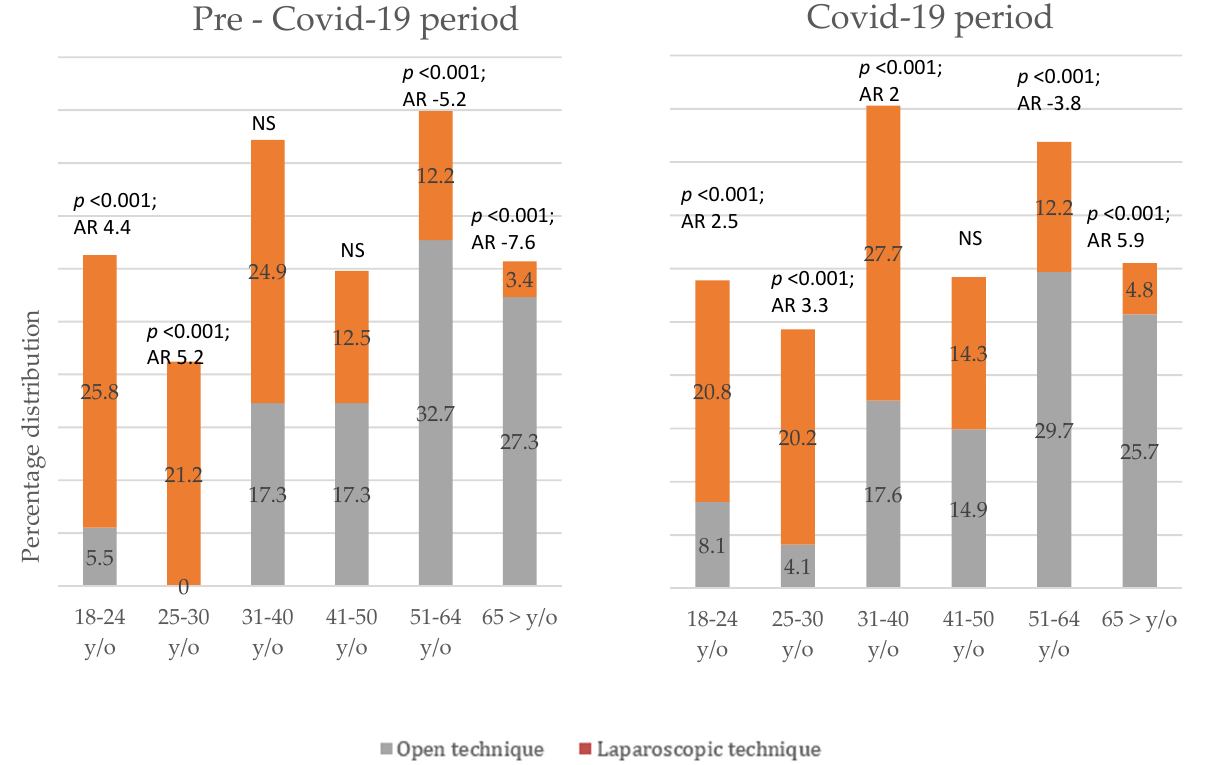
Figure 1. Distribution of open versus laparoscopic surgery in age groups. Table 3. Waiting time until surgery depending on radiological diagnostic modalities